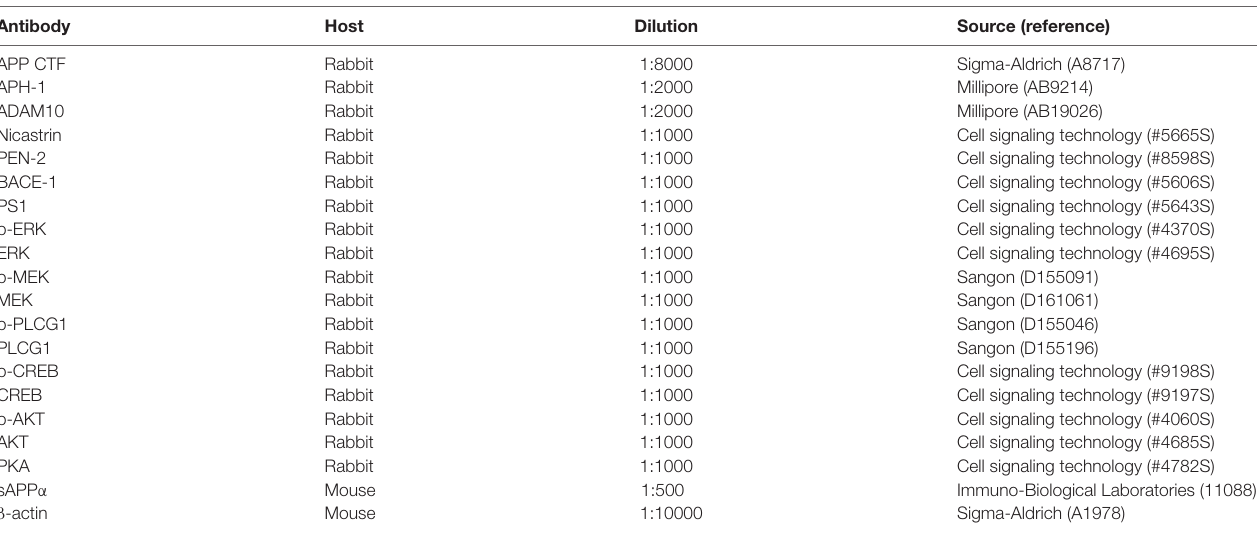
TABLE 1 | List of